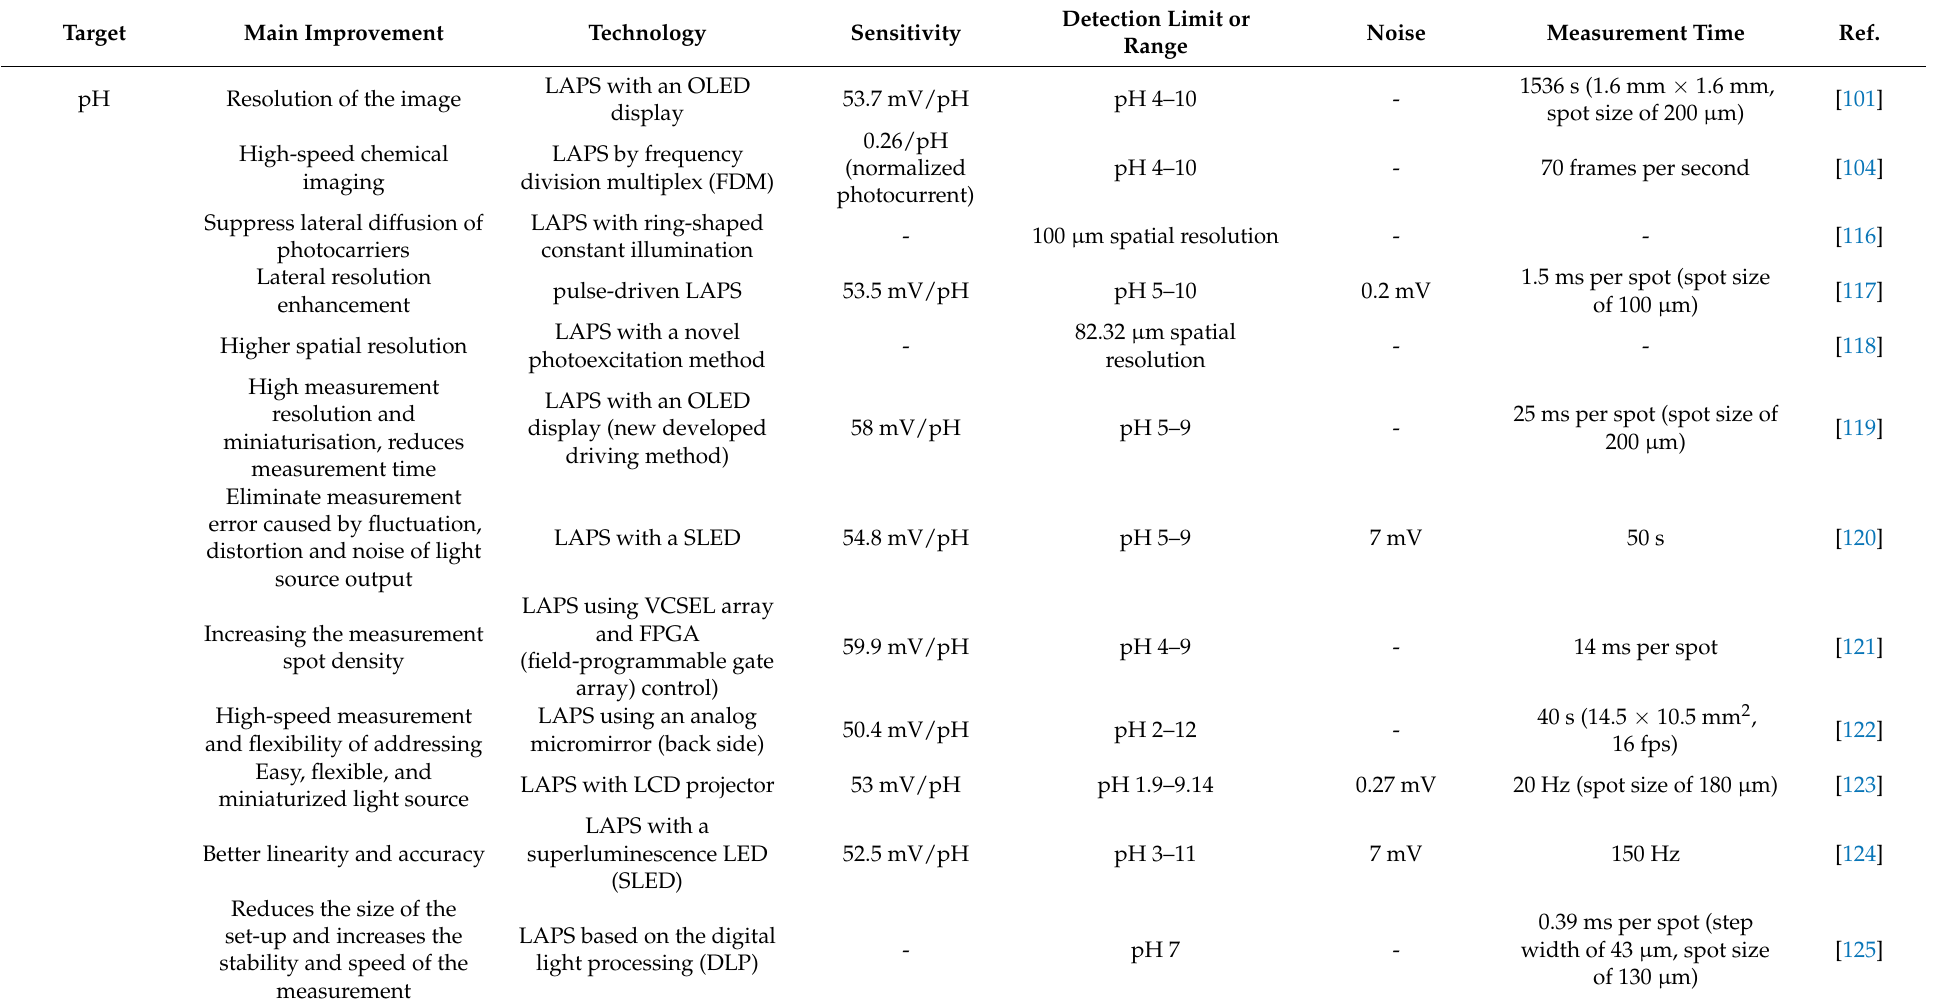
Table 5. Targets, main improvements, technology, detection limits or ranges, noise and measurement times of articles on the improvement of LAPS optical systems published in recent